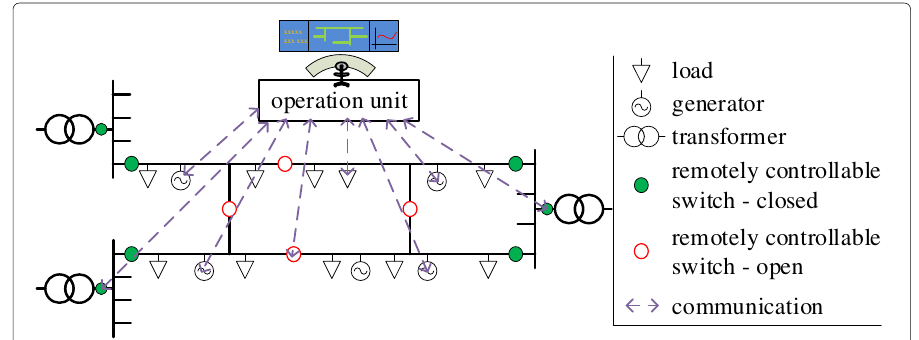
Fig. 5 Central operation architecture for a distribution grid operation based in the control center of the network operator. Source: Adapted from Drayer (2018)